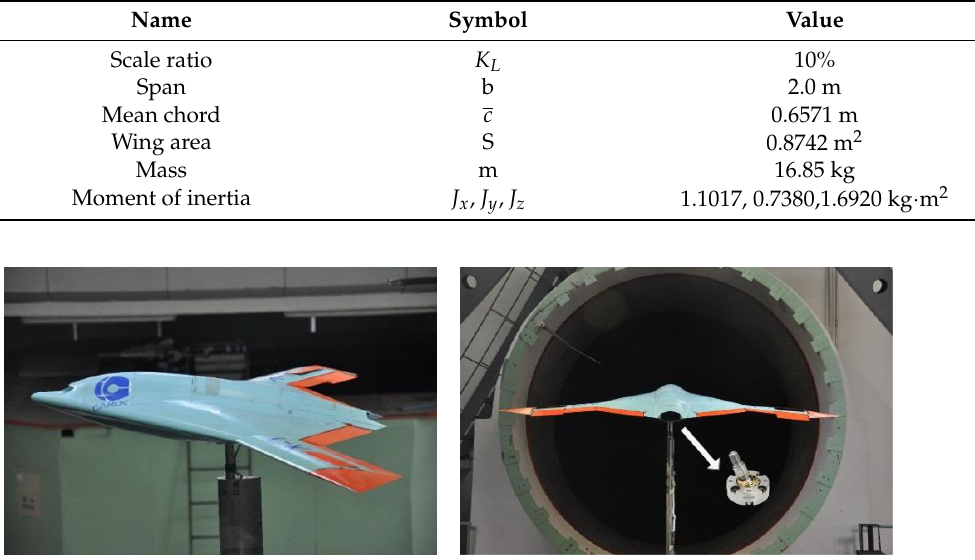
Figure 2. Tailless aircraft model flying on a three degree-of-freedom (3-DOF) dynamic rig in the wind tunnel. Table 1. Physical properties of the dynamically scaled aircraft model.